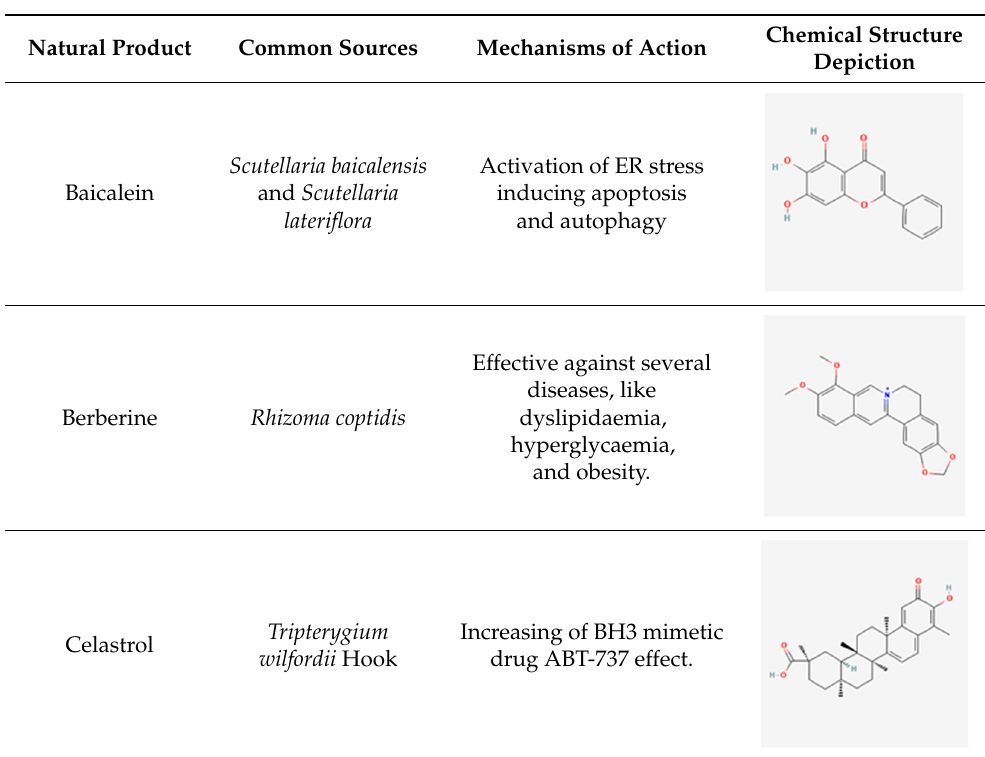
Table 1. Natural products affecting ER stress and UPR pathways. Natural Product Common Sources Mechanisms of Action